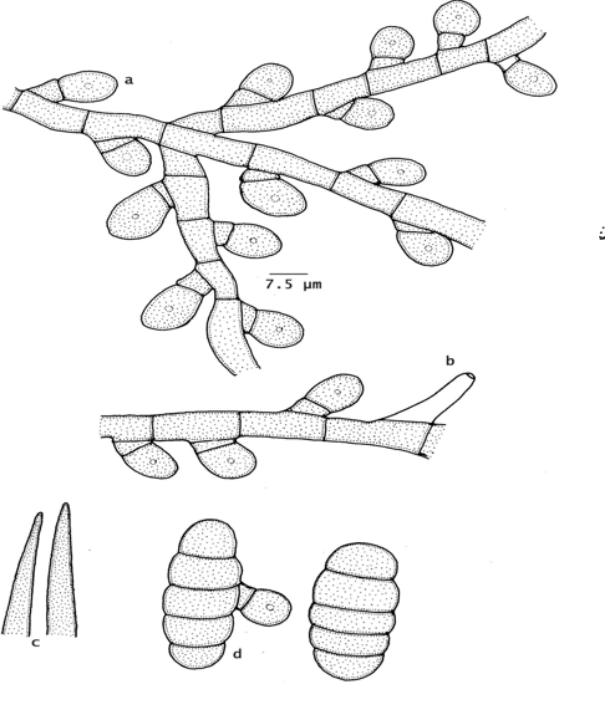
Figure 116. Meliola sterculiacearum a - Appressorium; b - Phialide; c - Apical portion of mycelial setae; d - Ascospores